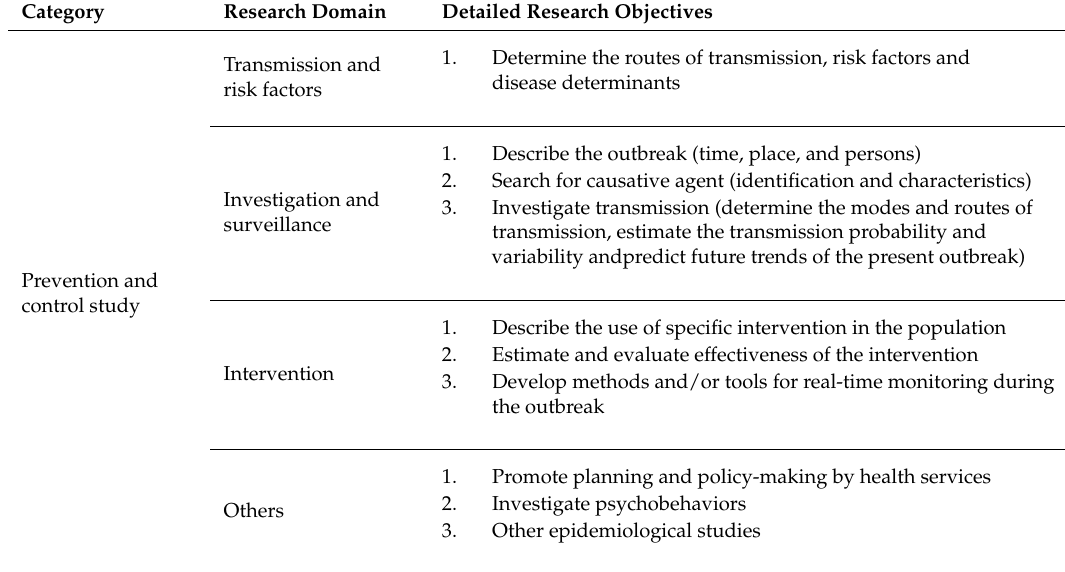
Table 1. Breakdown of the research